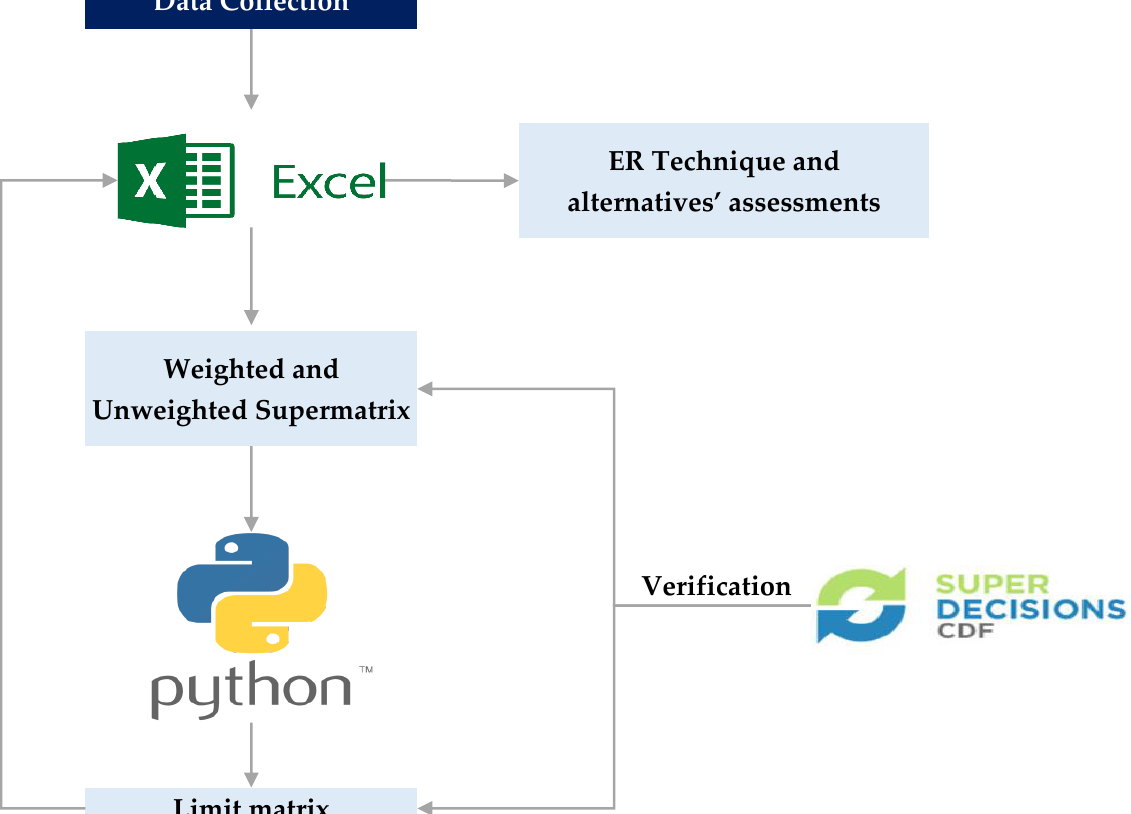
Figure 12. Verification approach of the ANP calculations .